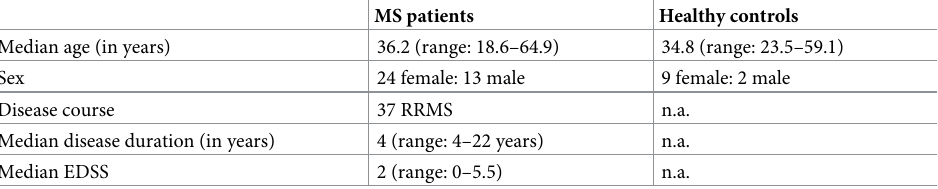
Table 1. Subject